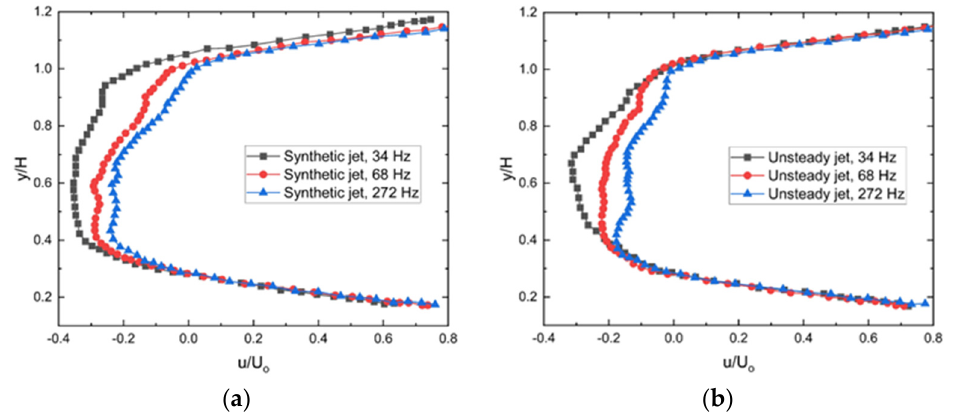
Figure 23. Vertical normalized streamwise velocity profiles measured at x/H = 0.5 in the symmetry plane with different actuator types at various control frequencies. ( a ) A synthetic jet; ( b ) an unsteady jet.